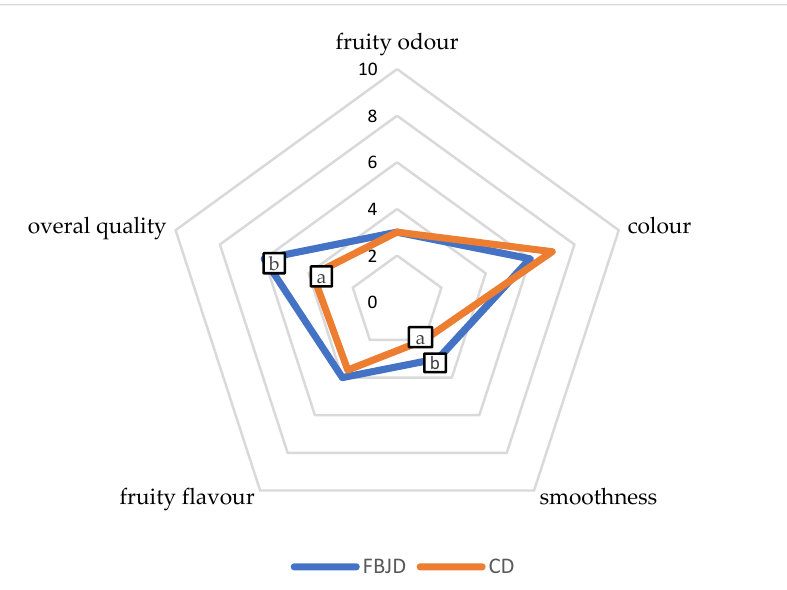
Figure 5. Comparison of the sensory quality of the drinks obtained by using the FBJD powders (method combined with pre-drying of fruits at 70 °C to a w 0.4) with the drinks obtained by using the CD powders (70 °C, a w 0.2). Values are means ± standard deviation; a,b—different letters in the same line are significantly different (Duncan’s test, p < 0.05); FBJD—fluidized-bed jet milling and drying; CD—convective drying.